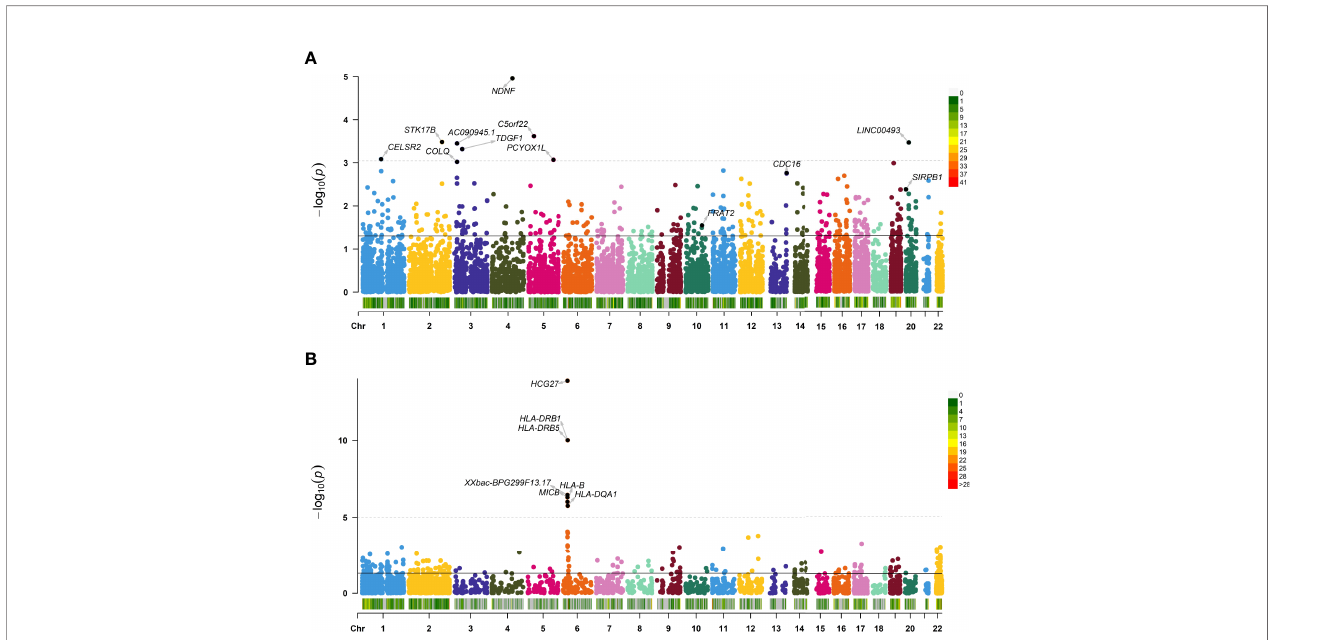
FIGURE 1 | Manhattan plot showing transcriptome-wide association study (TWAS) – identi fi ed genes. Manhattan plot showing TWAS-identi fi ed genes and signi fi cantly expressed genes associated with juvenile idiopathic arthritis (JIA; annotated points) for Asian (A) and European (B) populations. Each point represents a single gene, and the physical position (chromosome localization) is plotted on the x-axis, whereas the − log 10 ( P -value) of the association between gene and JIA is plotted on the y-axis. TWAS, transcriptome-wide association study; JIA, juvenile idiopathic